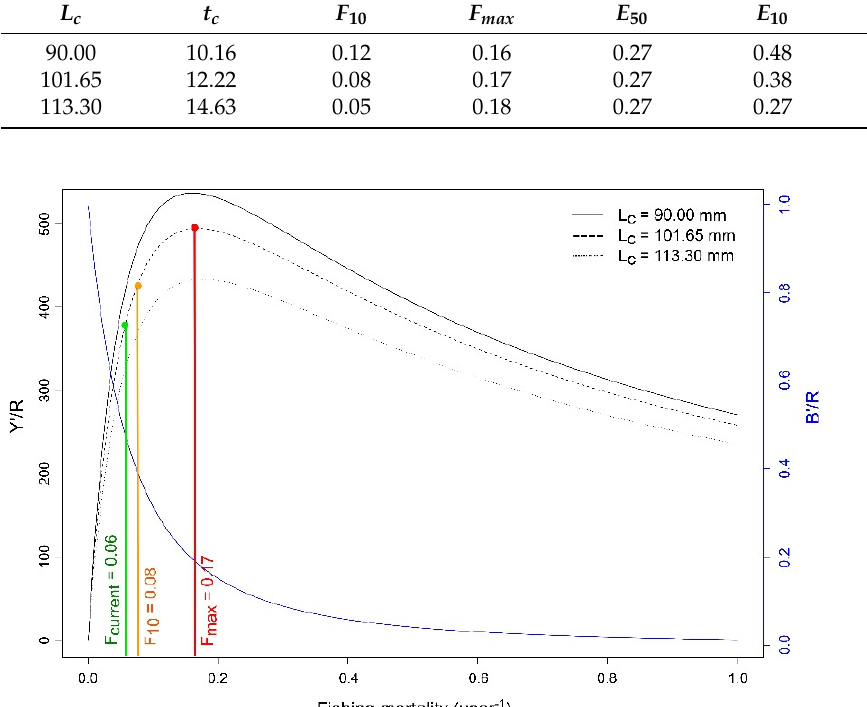
Figure 6. Relative yield–per–recruit (Y ′ /R; g year − 1 ) and biomass–per–recruit (B ′ /R; g) based on the model of Beverton and Holt (1957) for Palinurus elephas sampled in the Azores during the 2000–01 period. F current (year − 1 ): fishing mortality ( F ) found in the present study; F 10 (year − 1 ): fishing mortality rate corresponding to 10% of the slope of the Y ′ /R curve at the origin ; F max (year − 1 ): fishing mortality rate which produces the maximum Y ′ /R. L c : carapace length at first capture (mm).